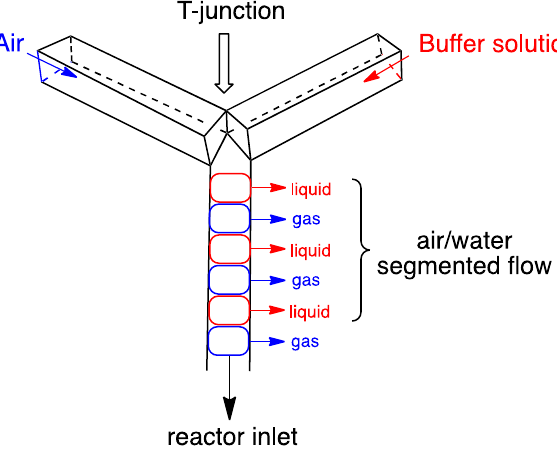
Figure 3. Schematic diagram of the experimental setup used to originate the segmented gas–liquid flow.